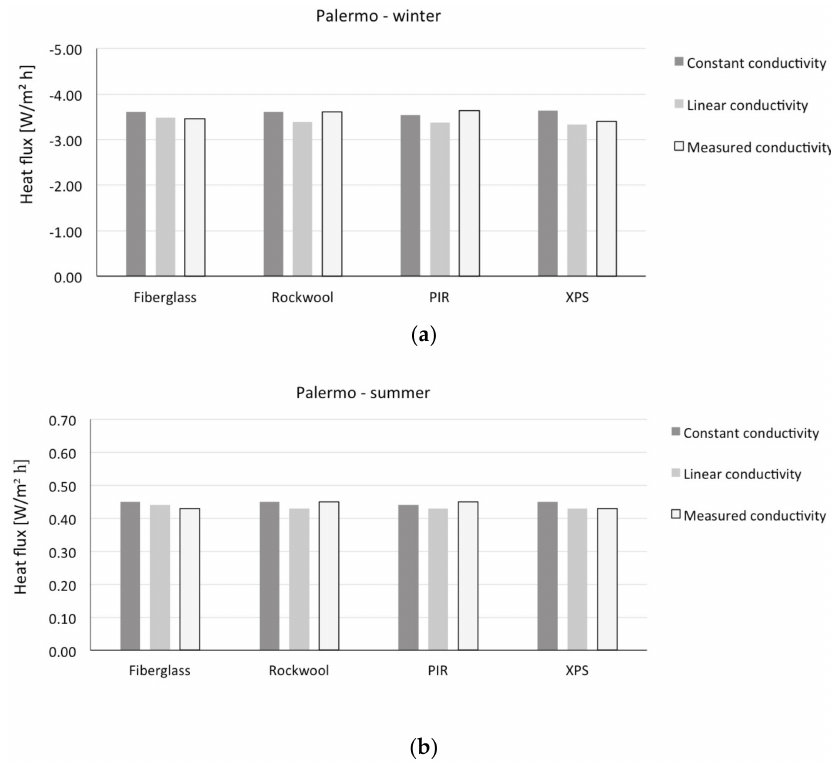
Figure 7. Heat flux average in exterior walls in Palermo. ( a ) Palermo—winter; ( b ) Palermo—summer.